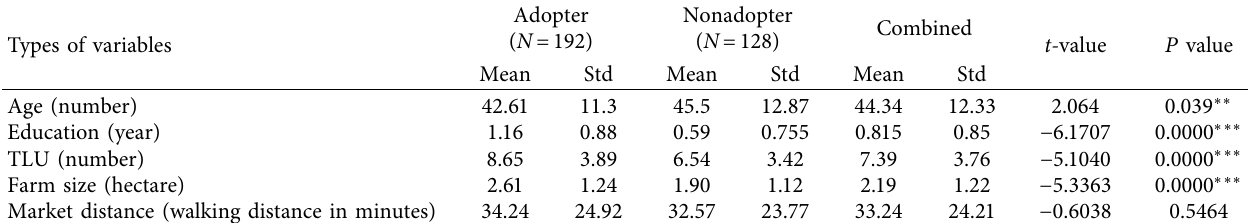
Table 3: Demographic and socioeconomic characteristics for continuous variables ( t -test).